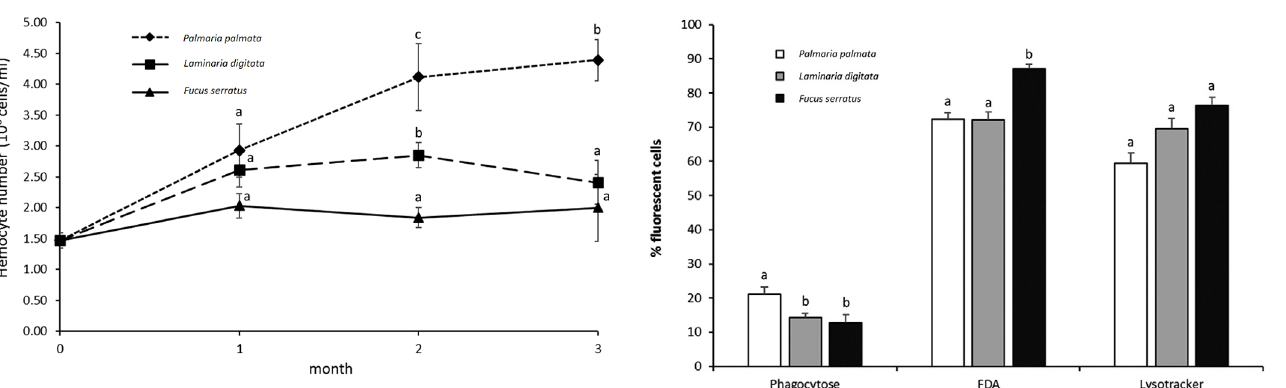
Fig. 3. Effect of diet on three immune parameters of abalone after three months of experimentation: Phagocytosis: phagocytic ef fi cacy; Fluorescein Diacetate (FDA): activity of non-speci fi c esterases; Lysotracker: lysosomal marker (Experimentation E6). Results are expressed as mean± SEM ( n = 9). Diets that do not share a letter differ signi fi cantly (ANOVA and SNK tests, p <